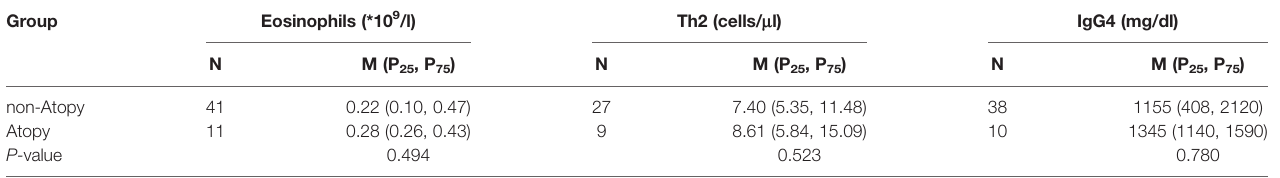
TABLE 3 | Comparisons of eosinophils, Th2 and serum IgG4 level in atopic and non-atopic patients with IgG4-RD. Group